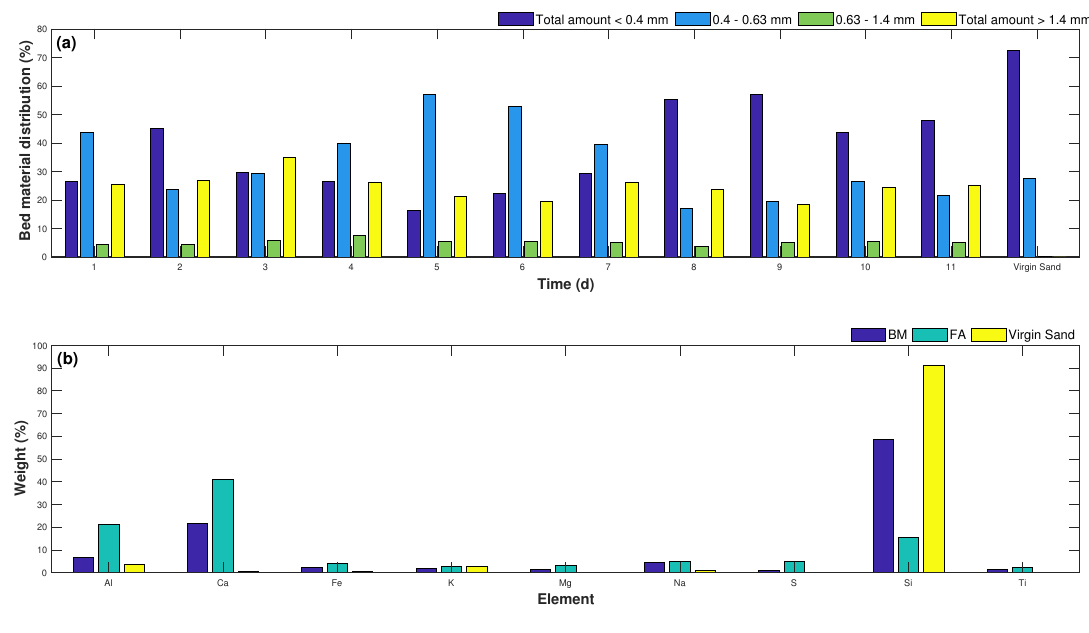
Figure 5. The percent in size distributions for the measured bed material ( a ), and the average percent composition of bed material (BM) and fly ash (FA), in comparison to virgin sand ( b ).